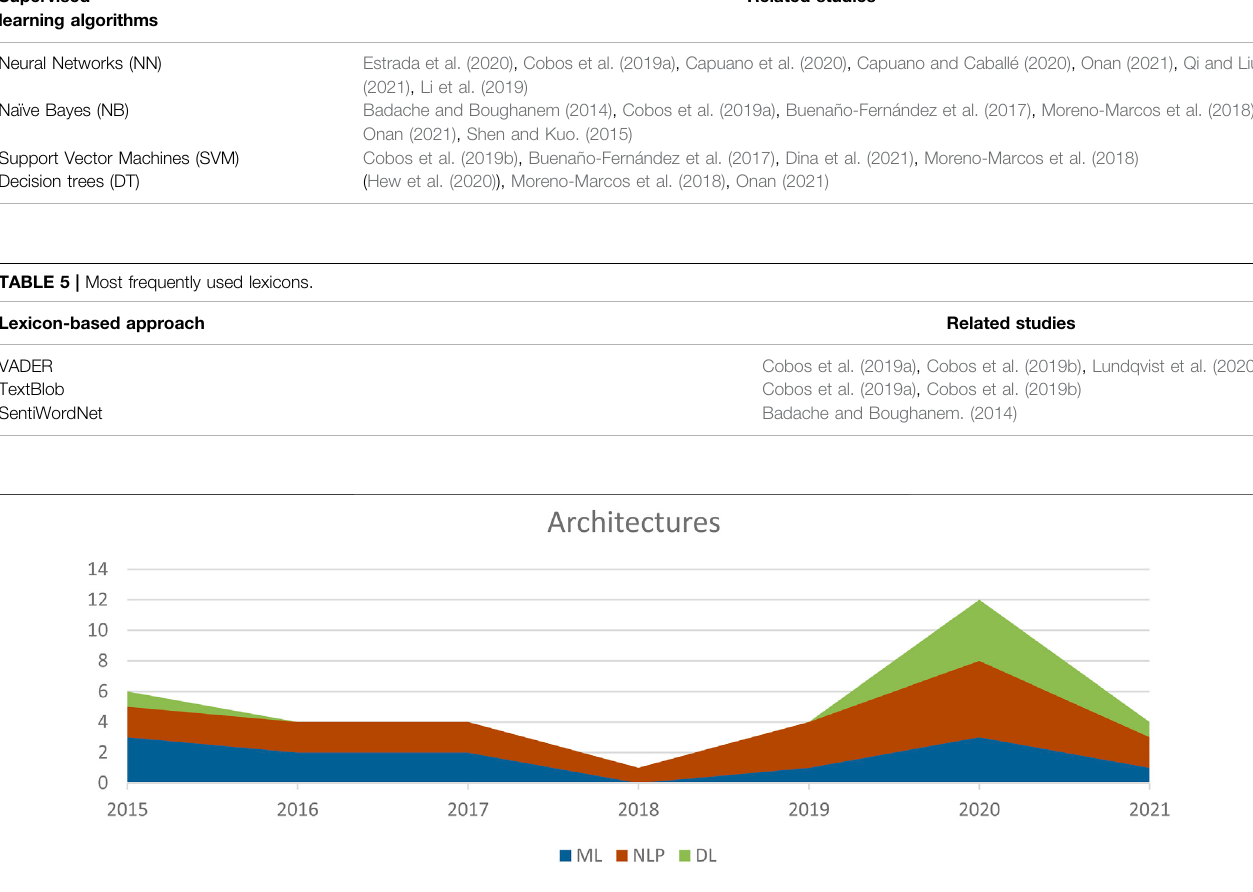
FIGURE 6 | Distribution of architectures during 2015 –